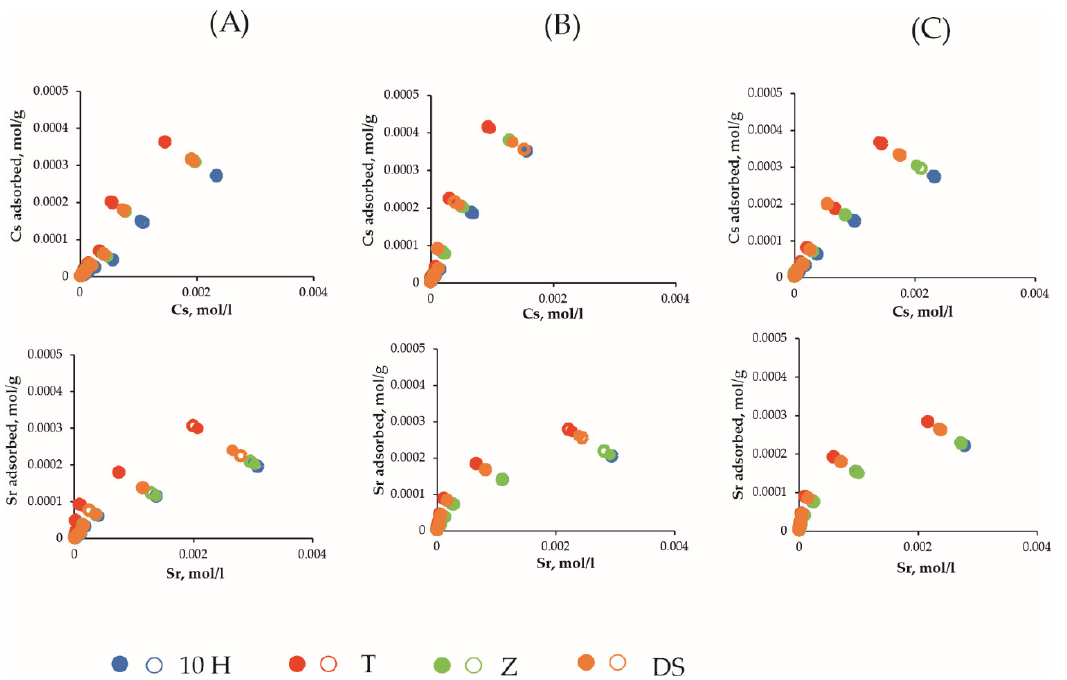
Figure 2. The recovery rate of Cs(I) and Sr(II) from solutions with pH 3 ( A ), 7 ( B ), and 10 ( C ) by bentonites 10H, T, Z, and DS. Empty and filled icons are replications of the experiment.